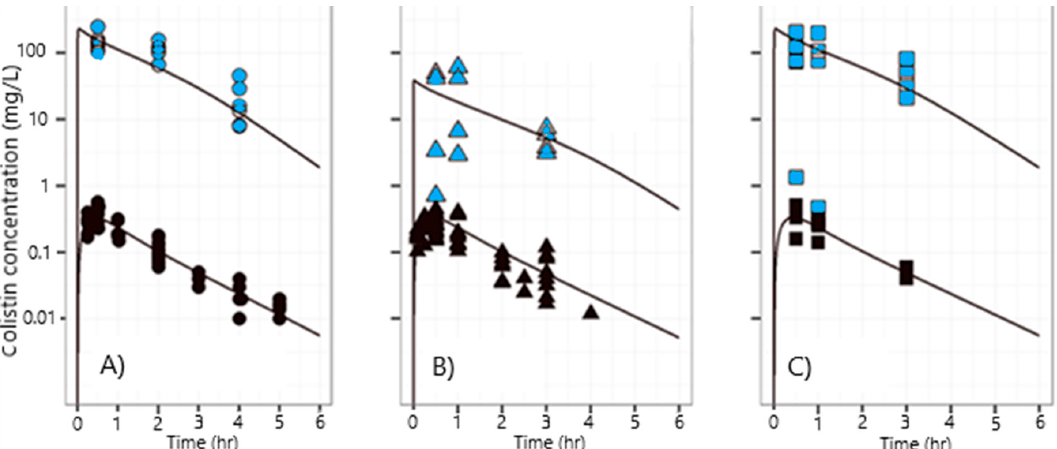
Figure 4. COLI concentrations measured in plasma (black symbols) and epithelial lining fluid (ELF) (blue symbols) and typical prediction of the model (solid lines) after intratracheal administration of ( A ) COLI solution as published by Gontijo et al. [17]; ( B ) INU-COLI dry powder; ( C ) COLI solution made by dissolving the INU-COLI powder. COLI dose delivered was 0.35 mg·kg − 1 (base form).